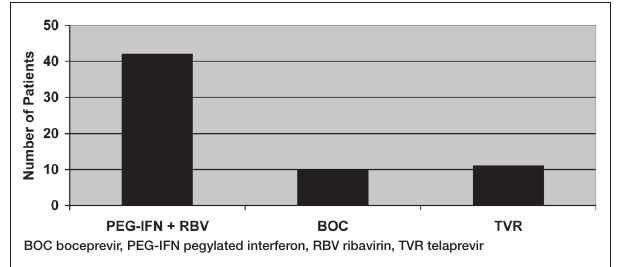
BOC boceprevir, PEG-IFN pegylated interferon, RBV ribavirin, TVR telaprevir Figure 2) Antiviral therapies initiated by hepatologists Table 2 Multivariate logistic regression for treatment initiation Subgroup and predictor